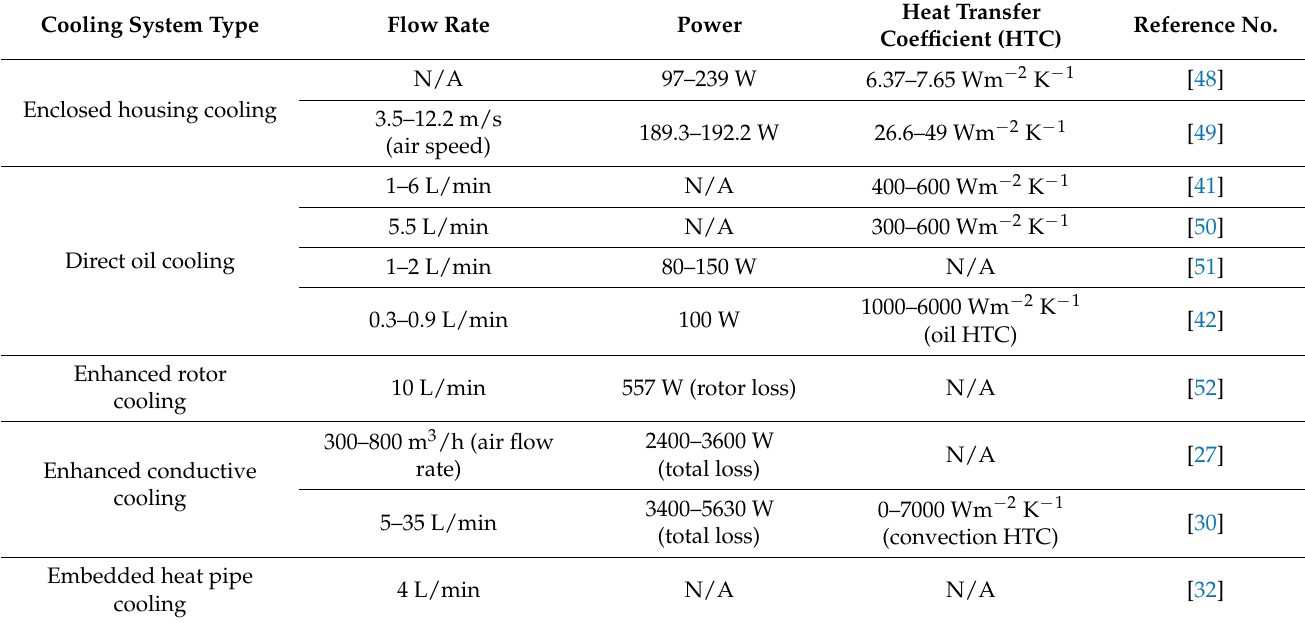
Table 2. Key parameters of different cooling